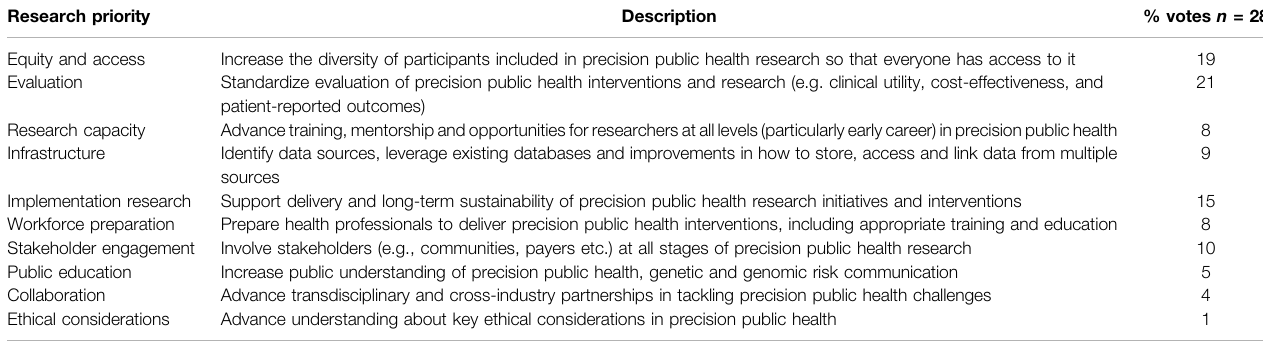
TABLE 2 | Precision public health research priorities: themes from breakout session one.